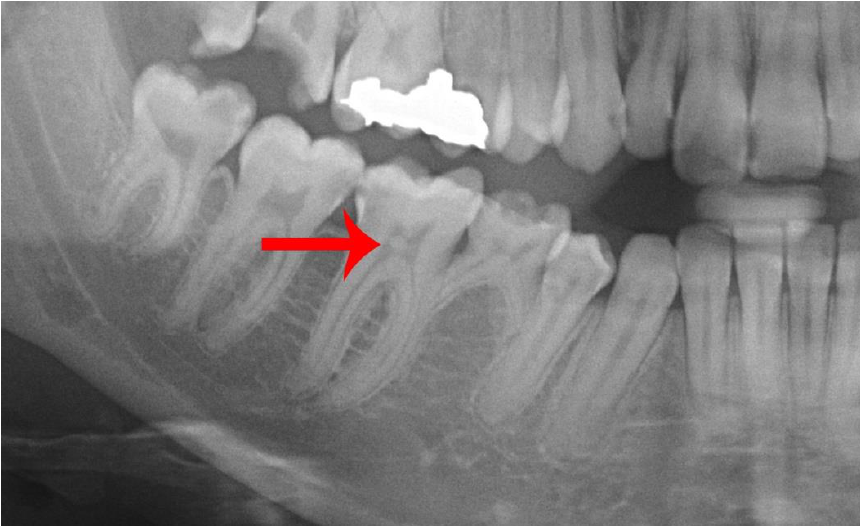
Figure 3. Close-up view of a panoramic radiograph showing idiopathic pulp stone within the coronal pulp chamber of the lower right first molar (Red arrow).